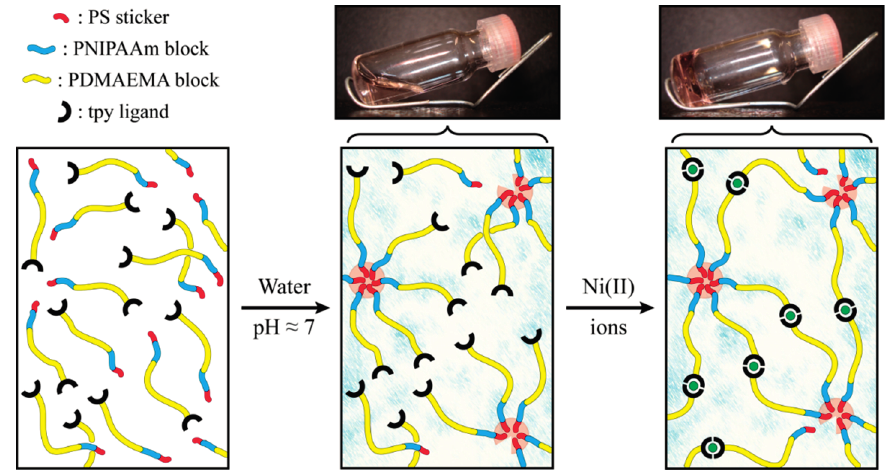
Figure 4. Schematic representations and illustrations of the hierarchical assembly of PS- b -PNIPAAm- b -PDMAEMA-tpy associating copolymers into a coordination micellar